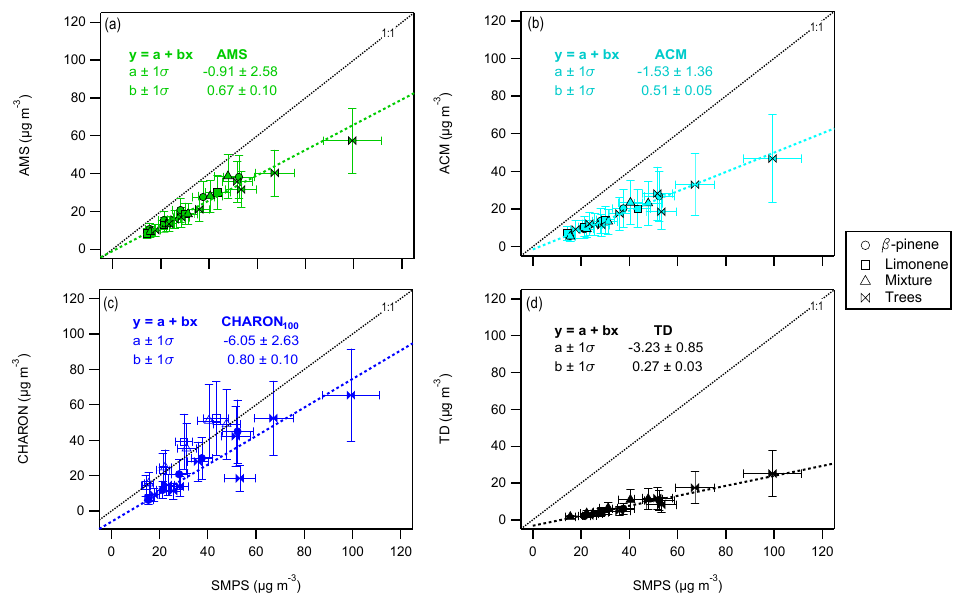
Figure 1. Comparison of the organic mass concentration of (a) AMS (green), (b) ACM (light blue), (c) CHARON 100 (blue) and (d) TD (black) to the SMPS ( x axis). Markers correspond to the different experiments, with the mixture experiment accounting for the mixture of β - pinene and limonene. AMS data presented are not corrected for collection efficiency. CHARON 100 corresponds to data taken only at 100Td E/N operating conditions. Error bars provide the uncertainty of each instrument (details in Sect. 2.3). A least orthogonal distance regression linear fit is applied for every instrument, taking into account all campaign measurement points. An exception is the CHARON limonene and mixture data (unfilled markers) that were excluded due to experimental flaws. Details of the coefficient values and their standard deviation are given on the upper left of each